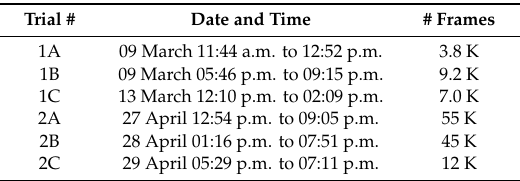
Table 1. ATM dataset collection trials characteristics.